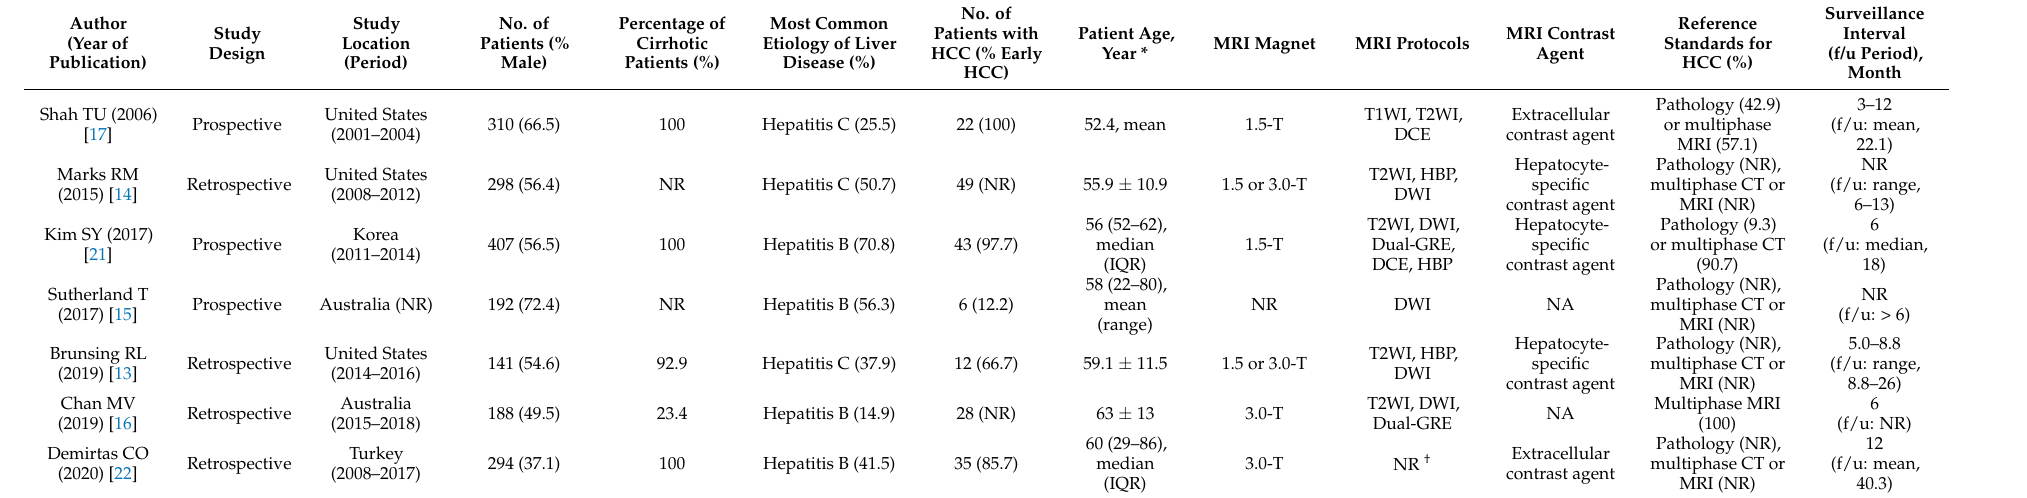
Table 1. Study characteristics of the seven